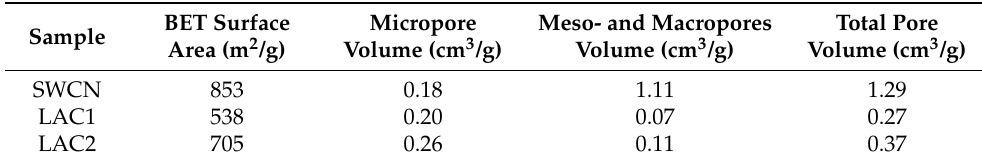
Figure 2. Adsorption isotherms of nitrogen at 77 K in various kinds of carbon (filled symbols for adsorption and unfilled symbols for desorption) in linear ( a ) and semi-log ( b ) scales. Table 3. Porous properties of carbons used in this study.